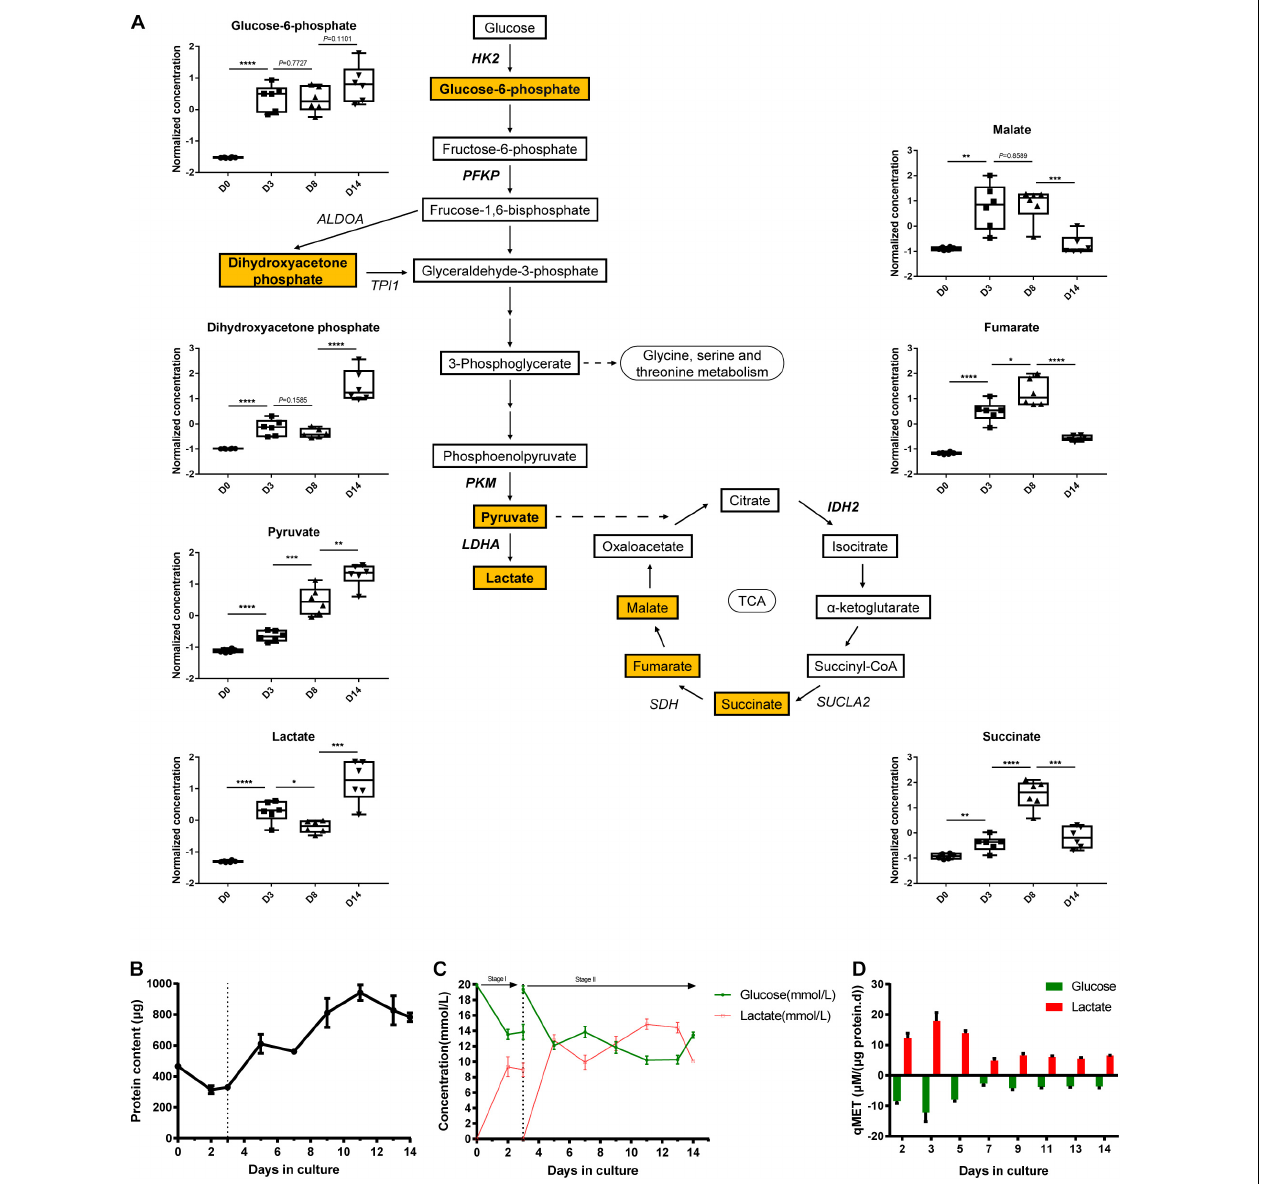
FIGURE 4 | Transcriptional and metabolic changes in glycolysis and TCA cycle. (A) Schematic of the glycolysis pathway and TCA cycle, the normalized and auto-scaled concentration of quantified metabolites are highlighted. (B) The total protein content of cells during the cultivation. (C) Concentration of extracellular residual glucose (green line) and lactate (red line) during differentiation. (D) Specific consumption rates of glucose (green column) and specific generation rate of lactate (red column) at different time points. The normalization of concentration of metabolites is described in methods. Data are presented as mean ± SEM from at least three biological replicates. * P < 0.05, ** P < 0.01, *** P < 0.001, and **** P <